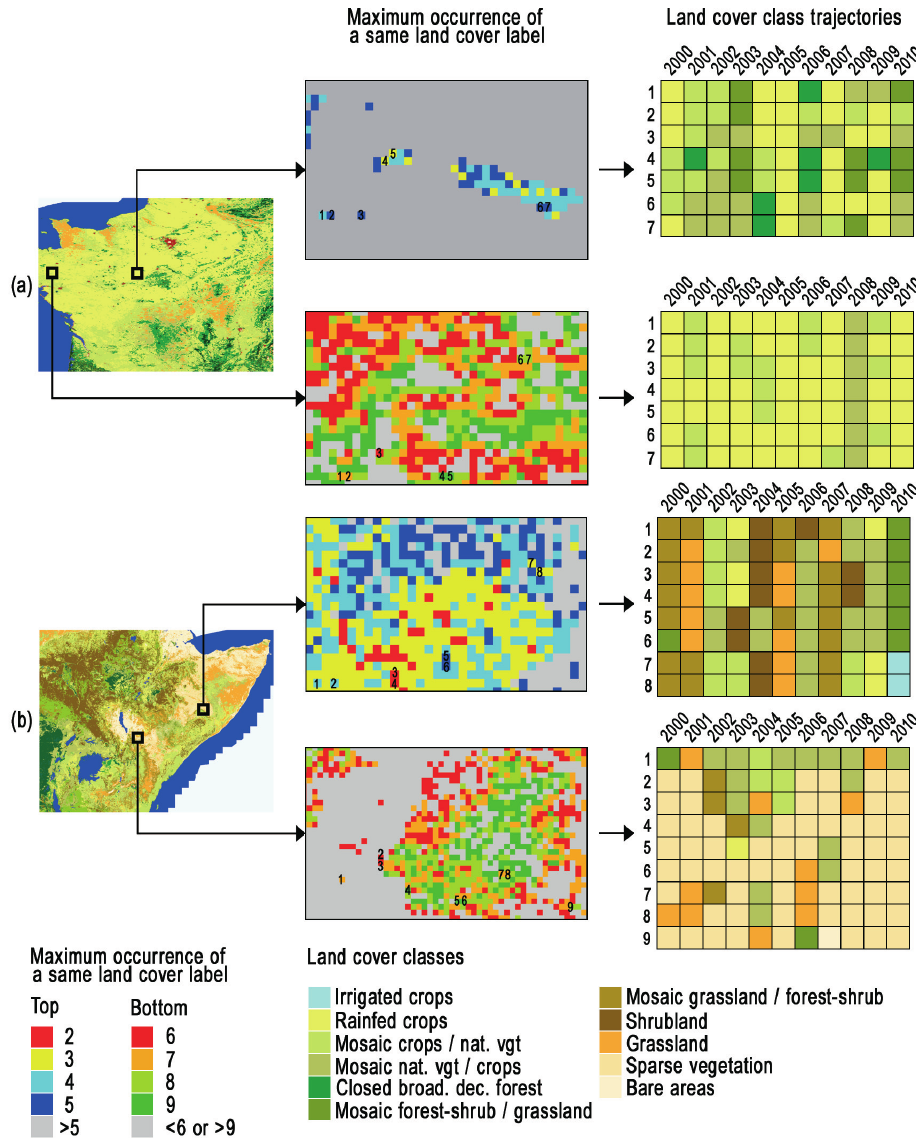
Fig. 6. Classification trajectories, over the 2000–2010 period, of pixels located in Europe (a) and Africa (b) . For both examples, trajectories of unstable and stable pixels are provided in top and bottom illustrations of (a) and (b) ,